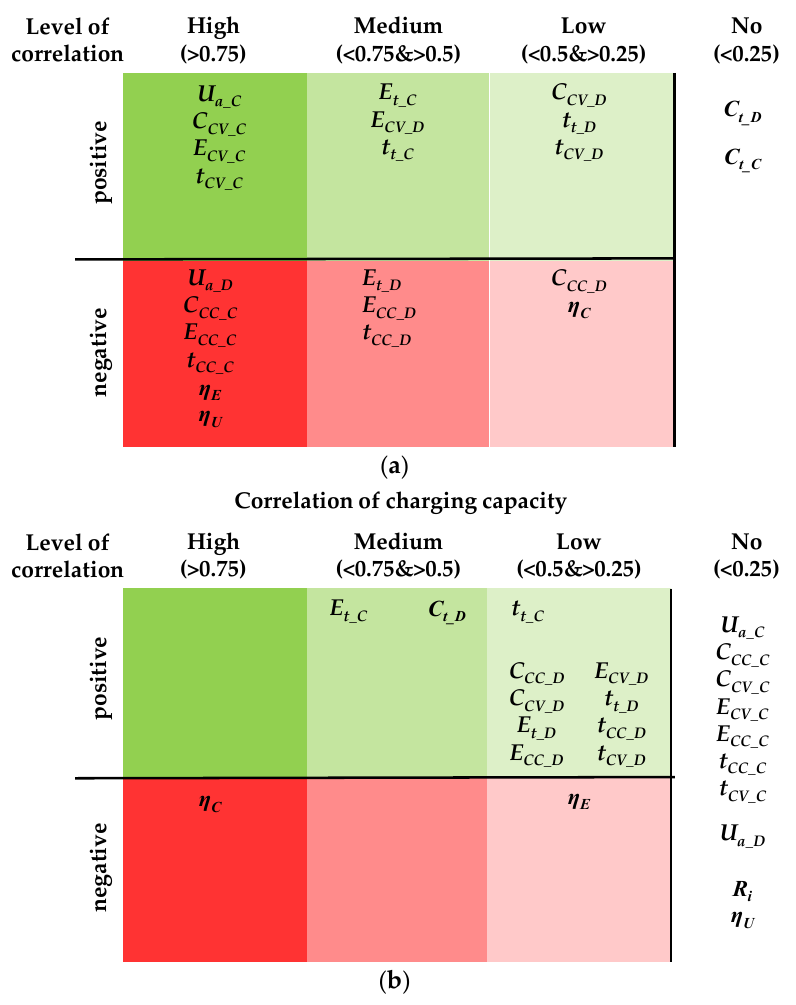
Figure 4. Results of the correlation analysis: ( a ) correlation of internal resistance with parameters and ( b ) correlation of total charging capacity with parameters.